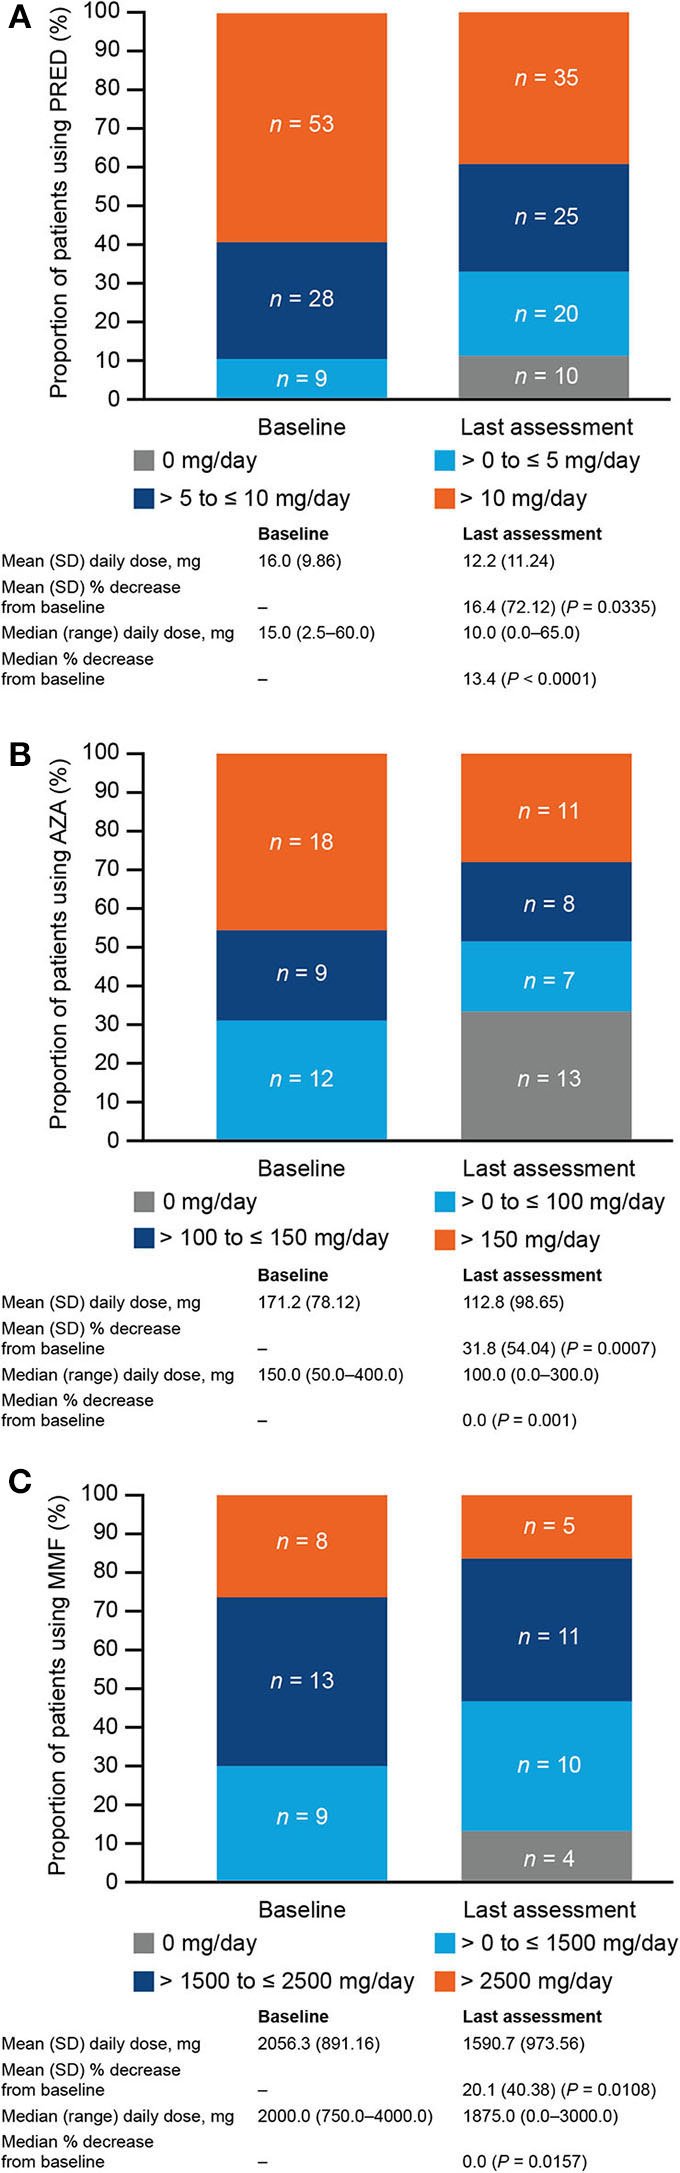
Immunosuppressive therapy (IST) doses at open-label extension (OLE) baseline and last assessment in patients using (A) prednisone and related corticosteroids (PRED; n = 90), (B) azathioprine (AZA; n = 39), or (C) mycophenolate mofetil (MMF; n = 30) at OLE baseline. A total of 90 patients were using PRED at OLE baseline, 39 were using AZA, and 30 were using MMF. The distribution of IST doses at OLE baseline and last assessment, mean and median daily doses at OLE baseline and last assessment, and mean and median dose reductions from OLE baseline to last assessment are shown for these patients. P-values for mean percentage changes were calculated using the one-sample t-test; P-values for median percentage changes were calculated using the Wilcoxon signed-rank test. SD, standard deviation.